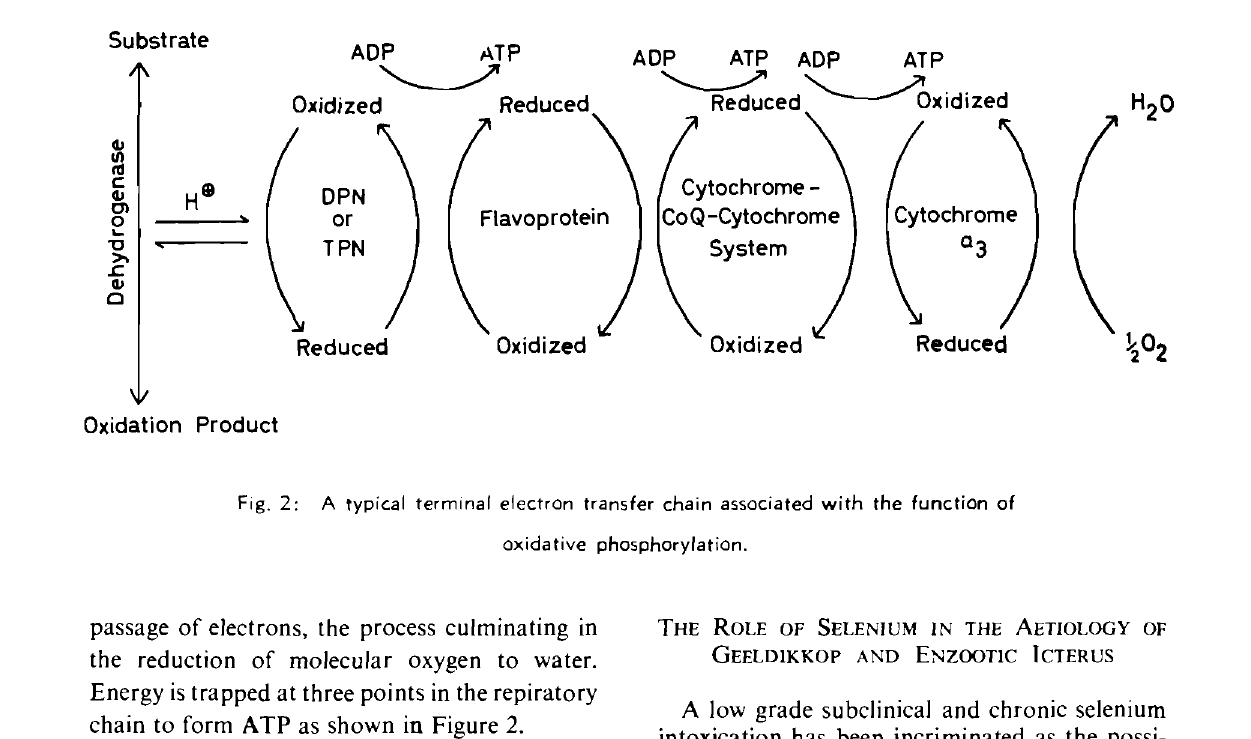
Fig. 2: A typical terminal electron transfer chain associated with the function of oxidative